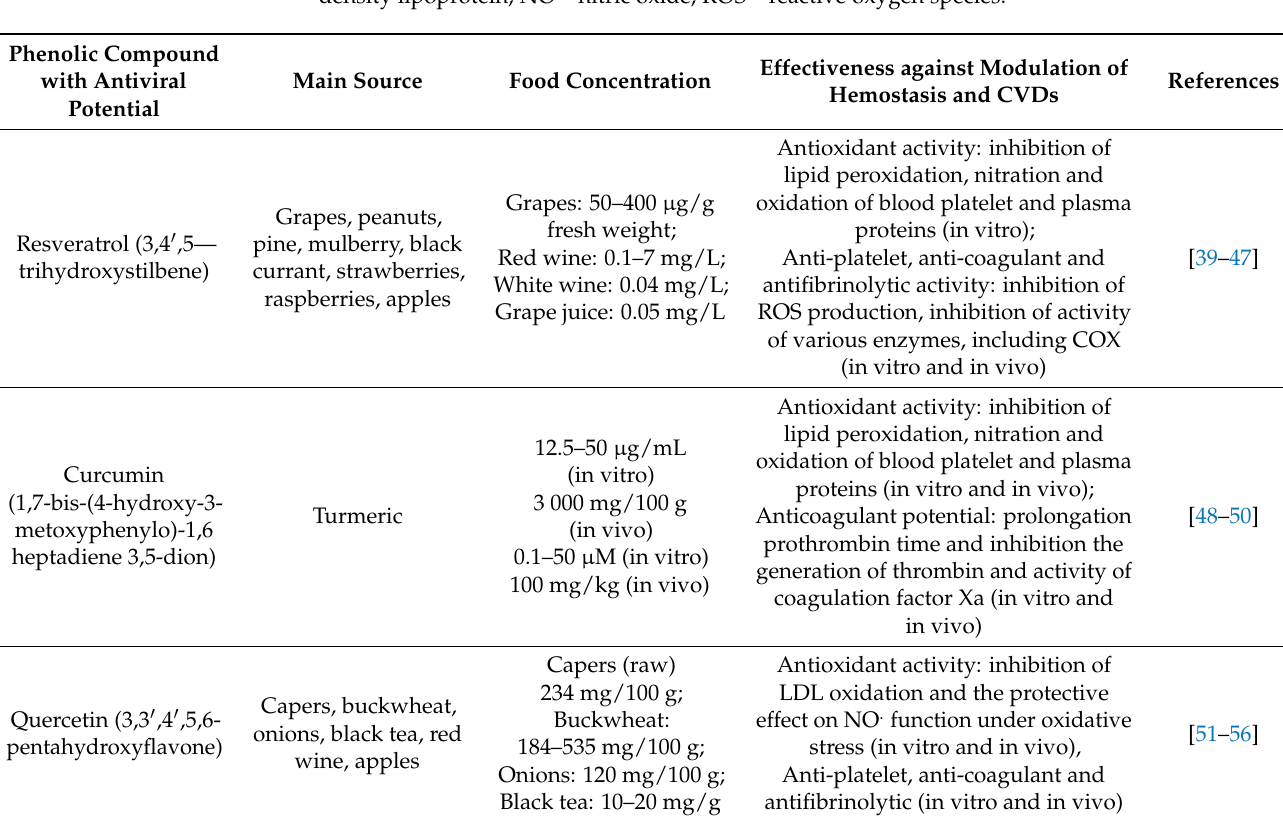
Table 1. Main dietary sources of phenolic compounds with antiviral potential and their effectiveness against modulation of hemostasis and CVDs [24]; (modified). COX—cyclooxygenase; LDL—low density lipoprotein; NO—nitric oxide; ROS—reactive oxygen